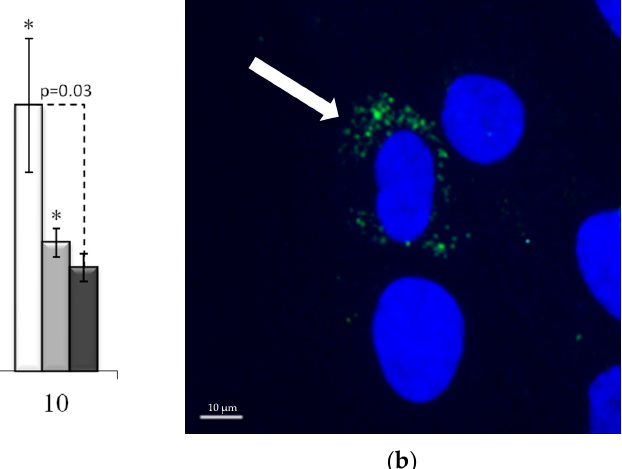
Figure 10. ( a ) Dose-dependent changes in the caspase-3 positive cell fraction in human fibroblasts 24 h, 48 h and 72 h after irradiation. Data are means ± SE of three independent experiments. * p < 0.05 and ** p < 0.01, *** p < 0.001—compared with the corresponding time of control; ( b ) Representative microphotograph of the immunocytochemically labeled cells with caspase-3 (caspase-3 positive cell with punctate caspase-3 (green) is marked with the arrow). Nuclei are counterstained with DAPI (blue).